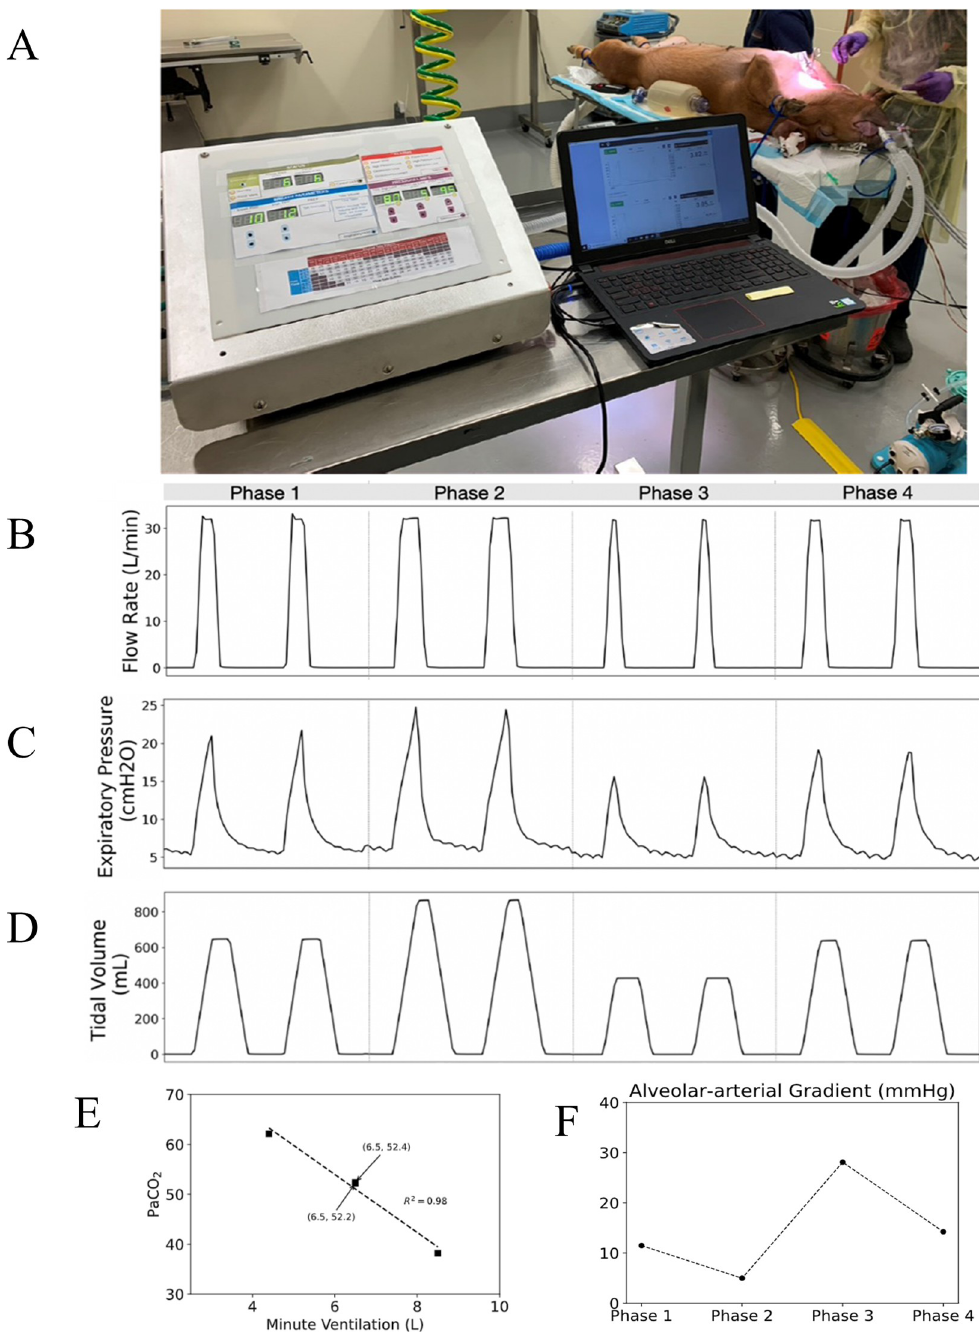
Fig 3. Ventilator and physiology results from the animal test. (A) The O2U ventilator performing mandatory ventilation on a sedated and intubated porcine subject. (B) Flow rate recordings during the different phases of the animal test, while the incoming flow rate, set on the flowmeter, was maintained at 33 L/min with each phase the inspiration time was changed to change the tidal volume, changing the width of the flow peaks. (C) The PEEP was maintained constant at 5 cmH 2 O during the test though the peak expiratory pressure measurements changed according to the current simulated ventilation treatment phase. (D) The tidal volume was the key controlled variable in the animal test with each phase targeting values to correspond to different desired physiological responses, these responses were measured in Table 3. (E) The relationship between the Minute Ventilation and the PaCO 2 showing the linear inverse relationship. (F) The A-a gradient during the different phases of the